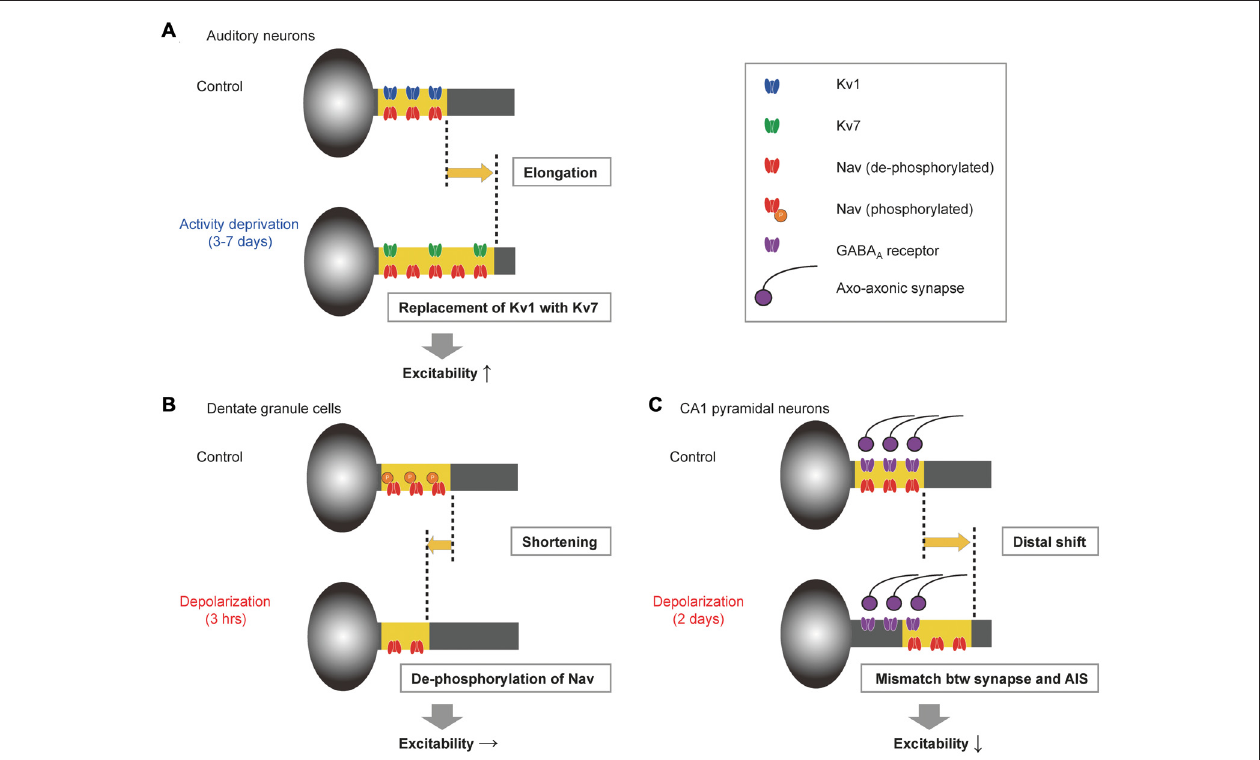
FIGURE 1 | Examples of structural and biophysical interaction during axon initial segment (AIS) plasticity. (A) In neurons of the avian cochlear nucleus, elongation of the AIS is accompanied by replacement of Kv1 with Kv7 at the AIS, which augments the effects of elongation on excitability (Kuba et al., 2015). (B) In hippocampal dentate granule cells, depolarization for 3 h shortens the AIS but simultaneously de-phosphorylates voltage-gated Na + (Nav) channels, which offsets the effects of shortening on excitability (Evans et al., 2015). (C) In hippocampal CA1 pyramidal neurons, depolarization for 2 days moves the AIS distally, but axo-axonic synapses remain at the original location, augmenting the suppressive effects of distal movement on excitability (Wefelmeyer et al., 2015).